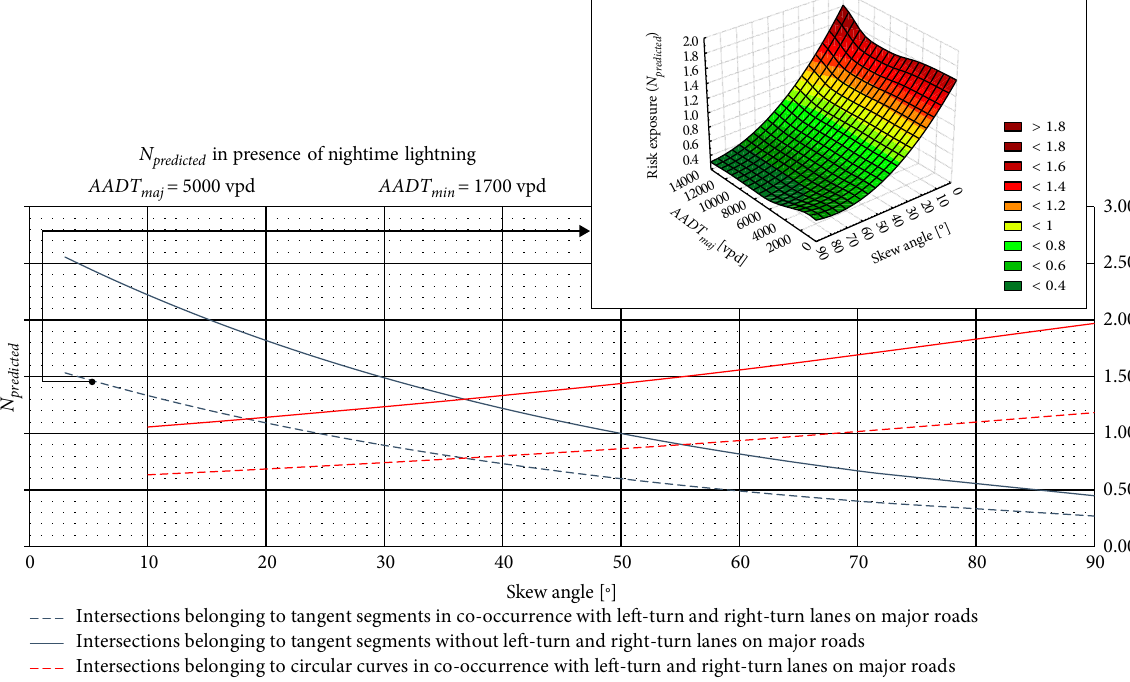
Figure 3: Risk exposure diagram at 3ST at-grade